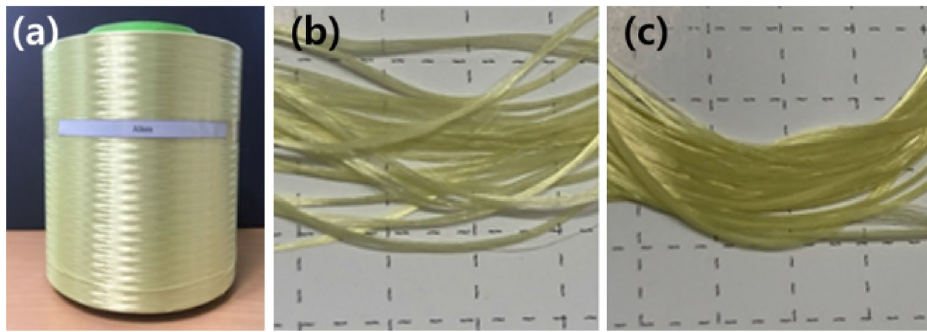
Figure 1. Para-aramid double-weave yarn: (a) para-aramid yarn (ALKEX), (b) 200 denier para-aramid yarn (surface), and (c) 400 denier para-aramid yarn